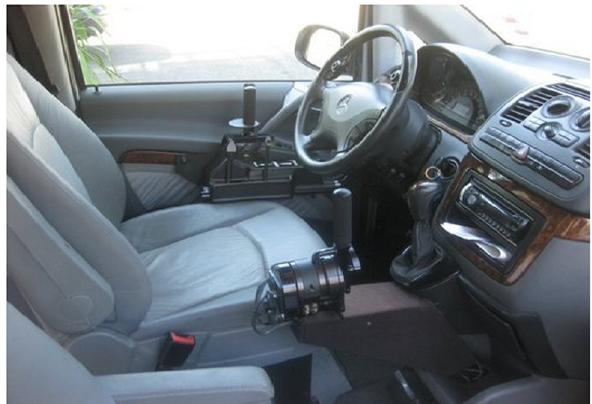
Figure 3: Vehicle control with